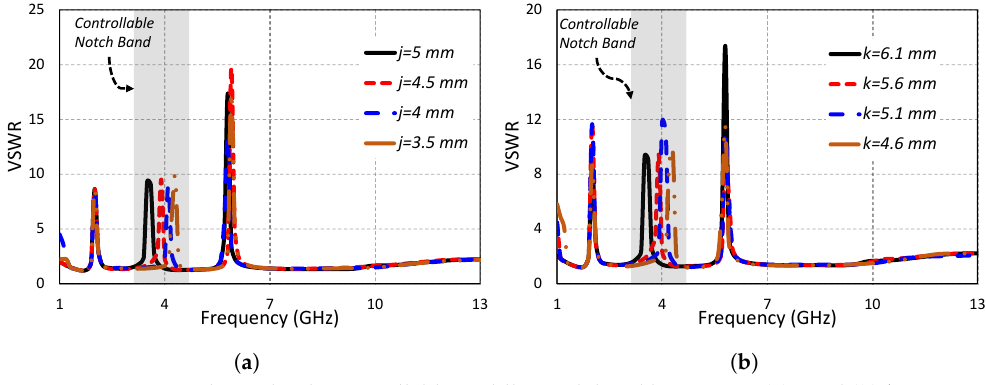
Figure 7. Independently-controllable middle notch band by varying ( a ) j and ( b ) k .